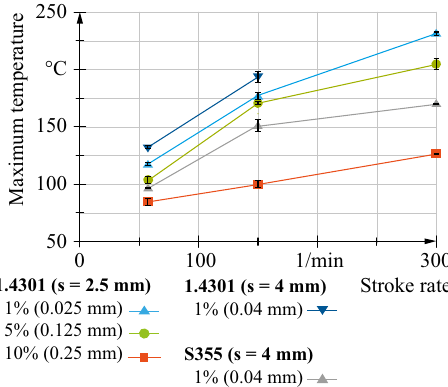
Fig. 4. Maximum temperatures occurring during embossing with clearances of 1%, 5%, and 10% for different materials over stroke